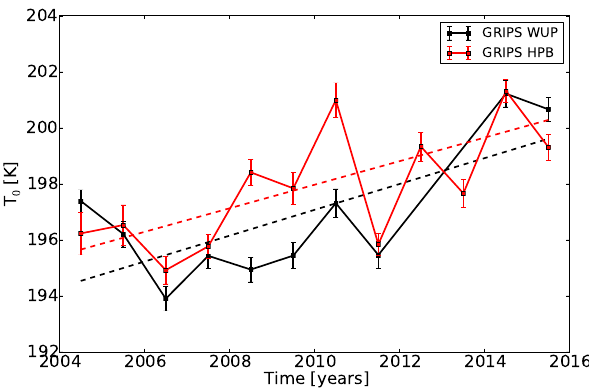
Figure 3. OH ∗ annual average temperatures for the two stations Wuppertal and Hohenpeissenberg in the time interval 2004–2015. The temperatures for Wuppertal (WUP) are shown in black and the temperatures for Hohenpeissenberg (HPB) in red. The dashed lines show the linear fits to the corresponding time series. The linear fit for the Hohenpeissenberg time series only considers measurements at times Wuppertal measurements are also